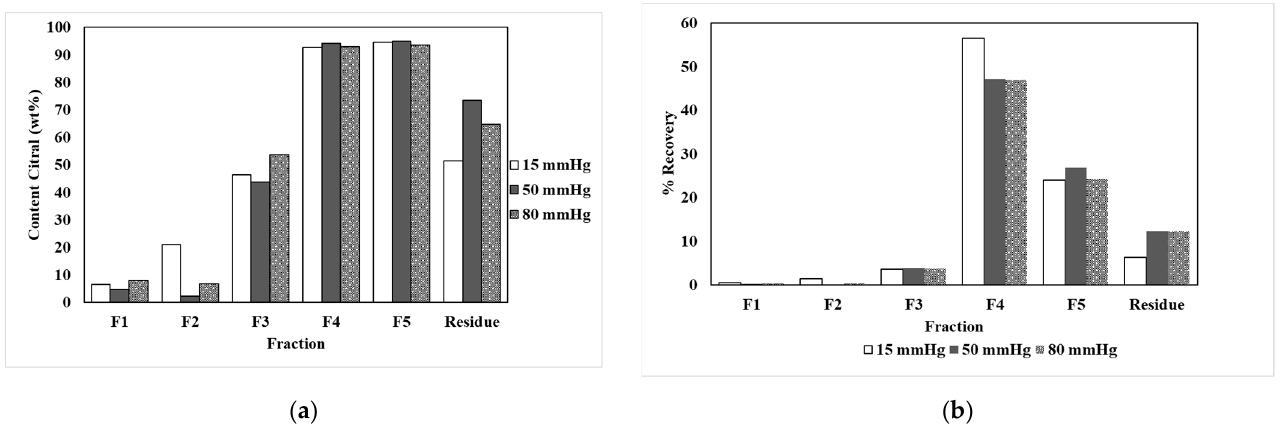
Figure 4. ( a ) Effect of vacuum pressure on the content of citral in the fractions; ( b ) Effect of vacuum pressure on the recovery of citral in the fractions.